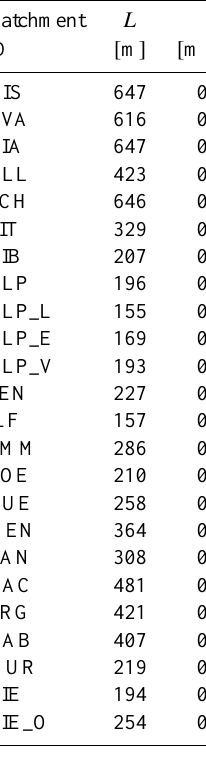
Table 3. Results of the topographic analysis. L is the flow-path length and G the flow